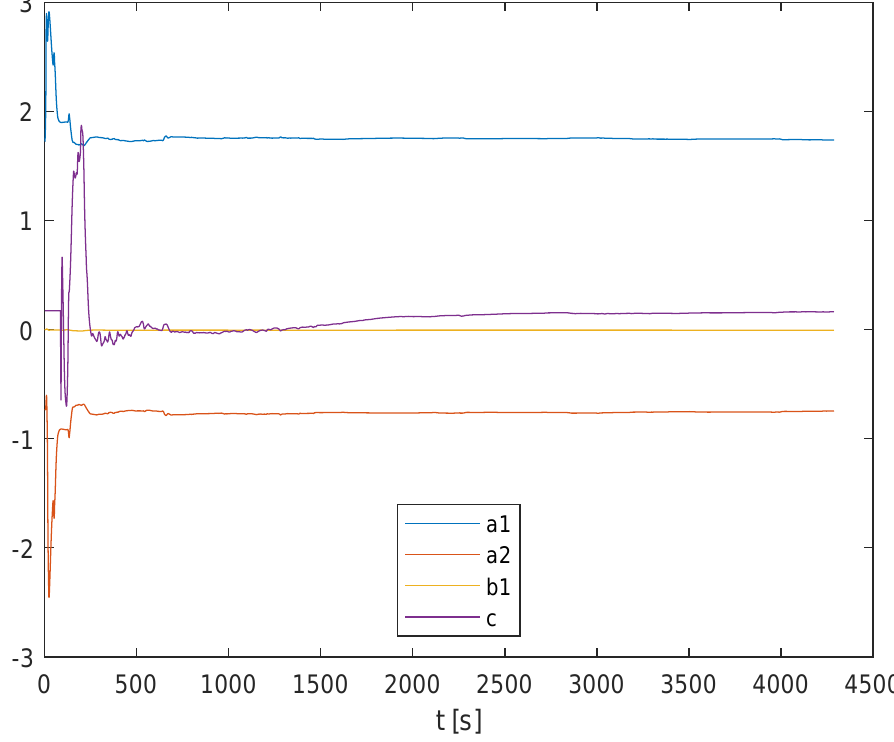
Figure 5. Online recursive parameter